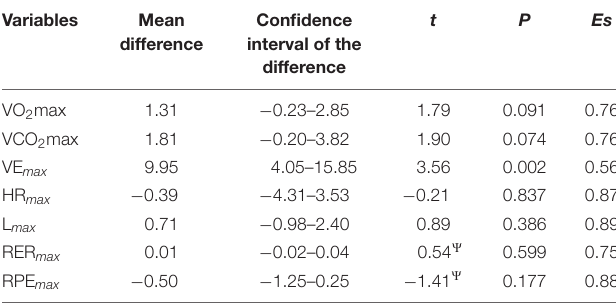
TABLE 2 | Paired samples t -test comparison between vibration and no vibration conditions.